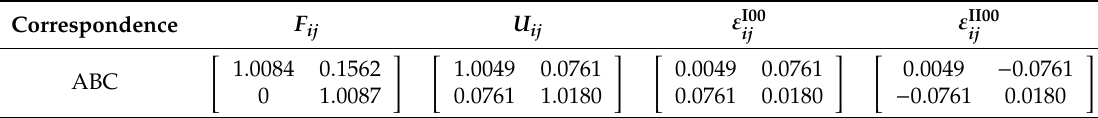
Table 1. Deformation gradient ( F ij ), right stretch tensor ( U ij ), and transformation strain ( ε 00 monoclinic variants